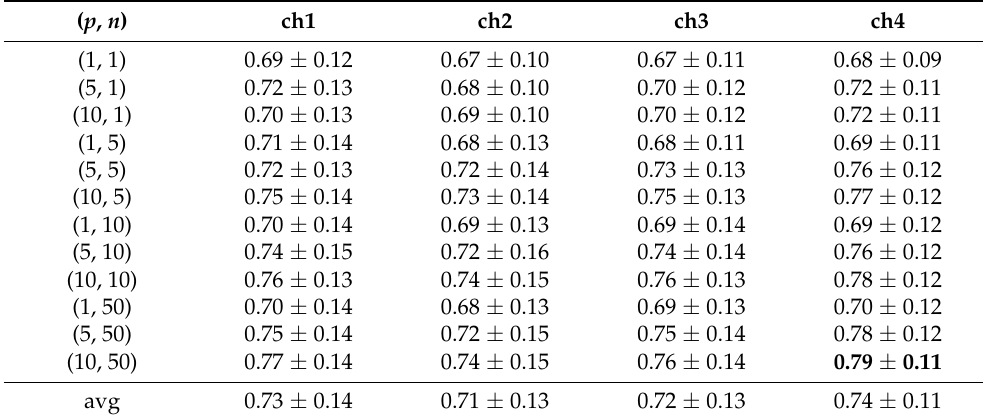
Table 6. A3S-Rec dataset: AUPRC of the 10-way 10-shot US8K prototypical model, considering internal labeling for the recordings of channels 1-2-3-4.